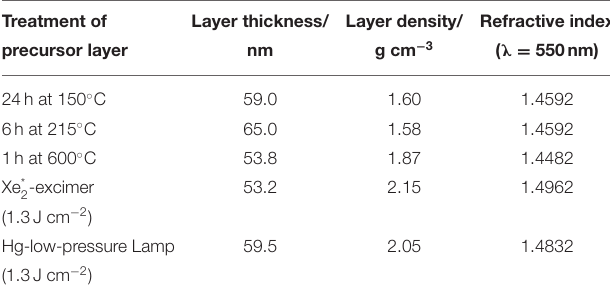
TABLE 1 | Densities and refractive indices of PHPS-layers treated with varying temperatures or VUV-irradiation regimes (Prager et al., 2014). Treatment